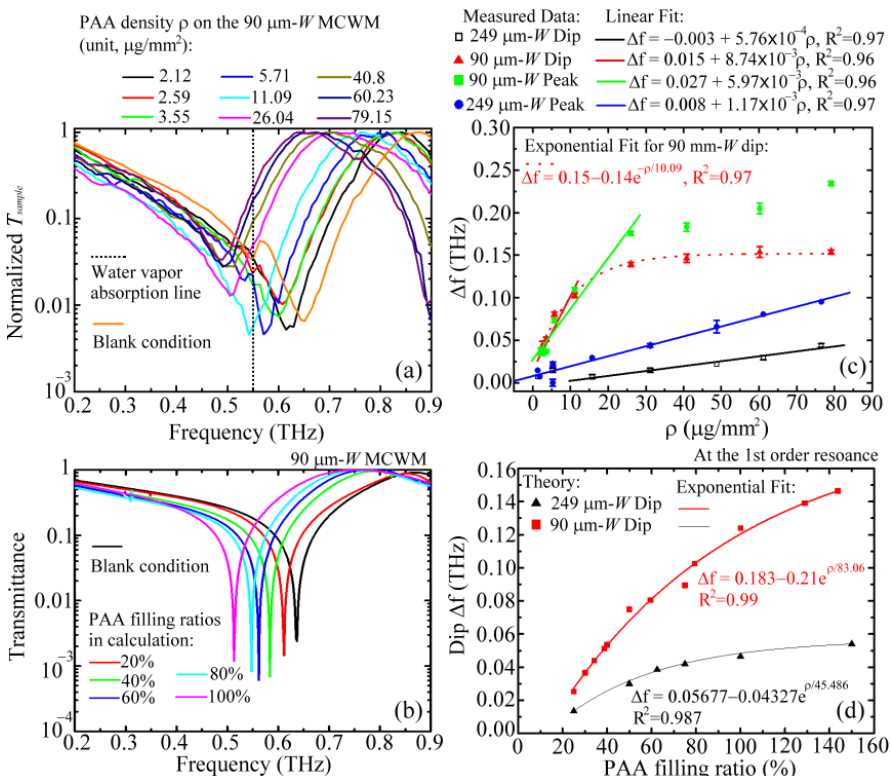
Figure 5. ( a ) Normalized transmittance of a 90 μ m W MCWM loaded with different weight densities of PAA membranes for thickness detection experiment; ( b ) calculated transmittance of a 90 μ m W MCWM with different filling ratios of PAA membranes; ( c ) relationship between spectral shift and PAA molecular density for the first spectral dips and peaks of 90 and 249 μ m W MCWMs; ( d ) calculated spectral dip shifts at the first-order resonance for the 90 and 249 μ m W MCWMs.